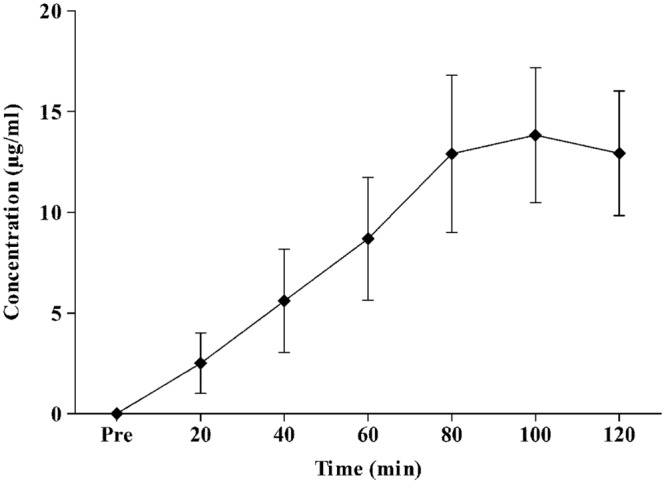
Mean ± standard deviation values for plasma APAP concentration response to oral intake of 20 mg⋅kg lean body mass-1 APAP during a resting two-hour period.